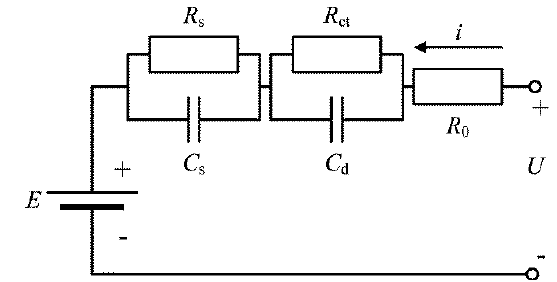
Figure 2. A typical equivalent circuit model for battery dynamics.